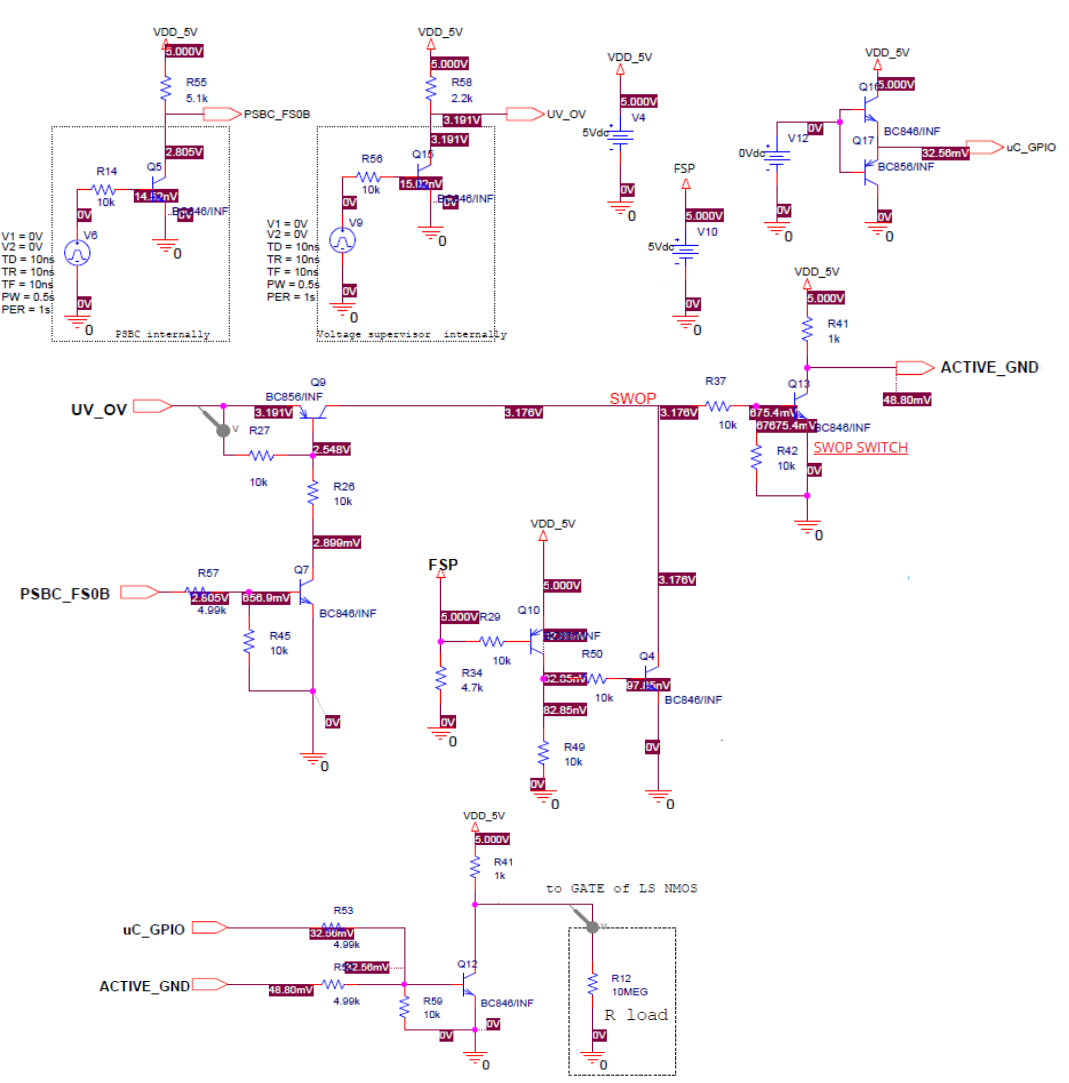
Figure 13. Simulation of safety switch-off path proposal for TCU safety activation.